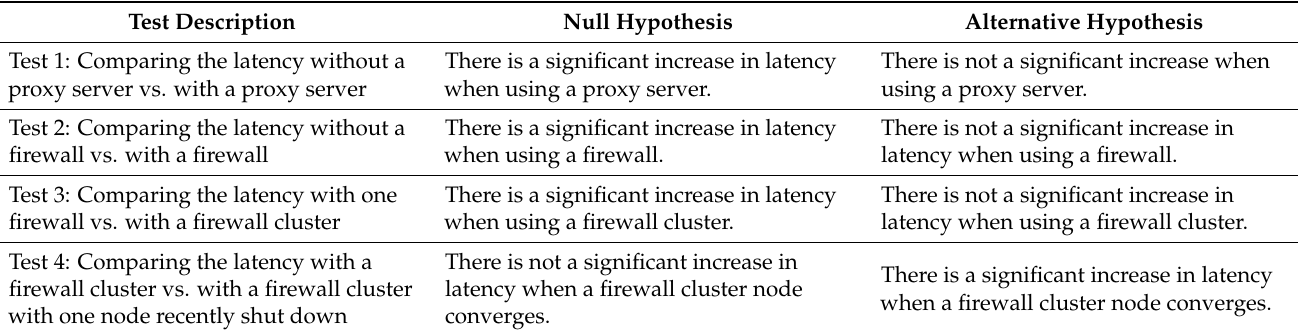
Table 3. Null and alternative hypotheses for each t -test.